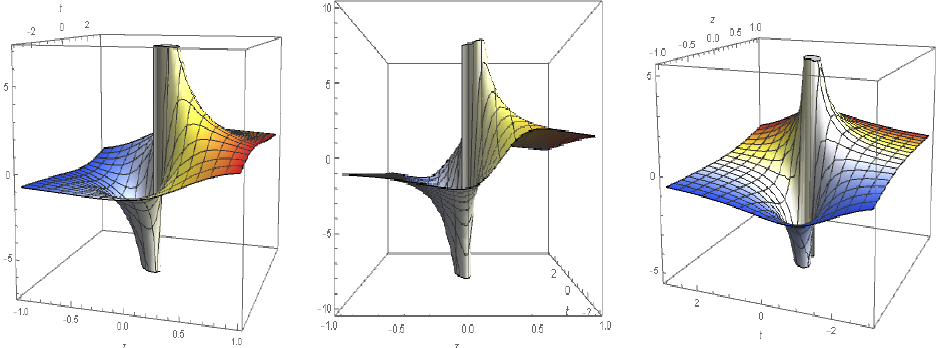
Figure 1. The lump profiles of the solution ∆ 1 in Equation (7) are presented via distinct parameters ω = 1. Three-dimensional profiles at (i) a 1 = 5, (ii) a 1 = 10 and (iii) a 1 = −